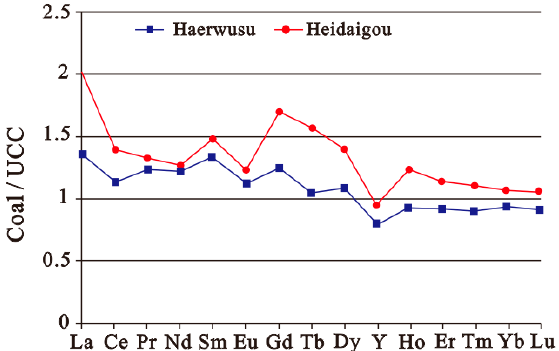
Figure 19. Comparisons of REY distribution patterns among the Heidaigou and Haerwusu coals. REY are normalized by Upper Continental Crust (UCC) [69].